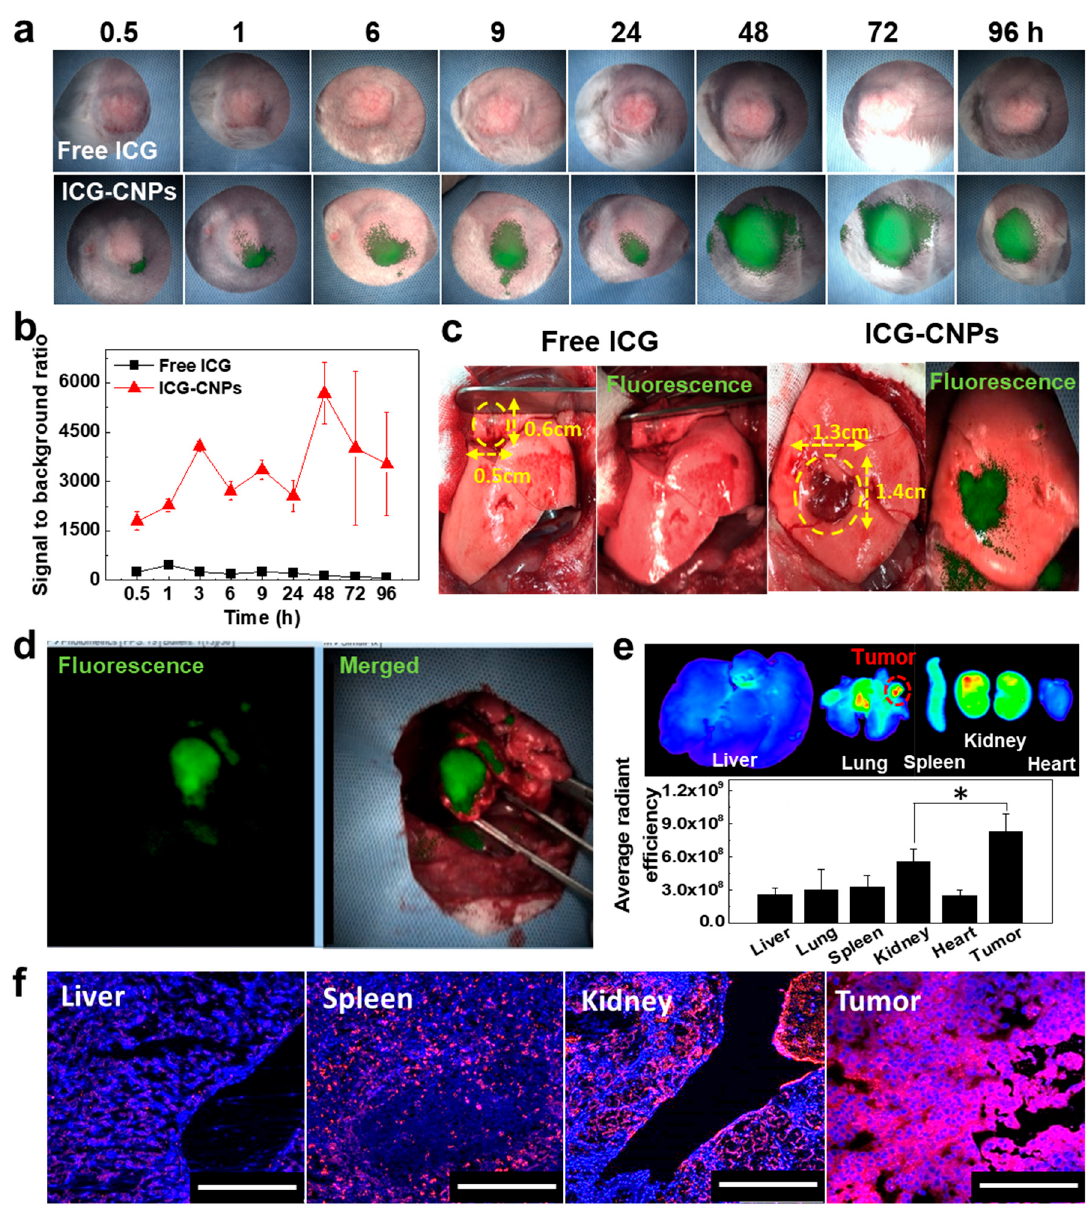
Figure 5. Tumor accumulation of free ICG and ICG-CNPs in rabbit VX2 tumor models ( n = 3) and image-guided surgical removal of orthotopic VX2 lung tumors in rabbit models ( n = 3). ( a ) Non-invasive NIRF imaging of VX2 tumors using ICFIS. ( b ) Signal to background ratios from ( a ). ( c ) White light-overlaid NIRF images of the surgical region at 96 h after the injections of free ICG and ICG-CNPs. All the data show differences at the p < 0.01 significance level. ( d ) The monitoring of the ICFIS instrument during the surgery. ( e ) Ex vivo NIRF images and signals in major organs and tumor tissue. Red dotted circle indicates tumor site. (*) indicates difference at the p < 0.05 significance level. ( f ) Tissue fluorescence images of liver, spleen, kidney, and tumor from orthotopic VX2 lung tumor model at 96 h post injection of ICG-CNPs.